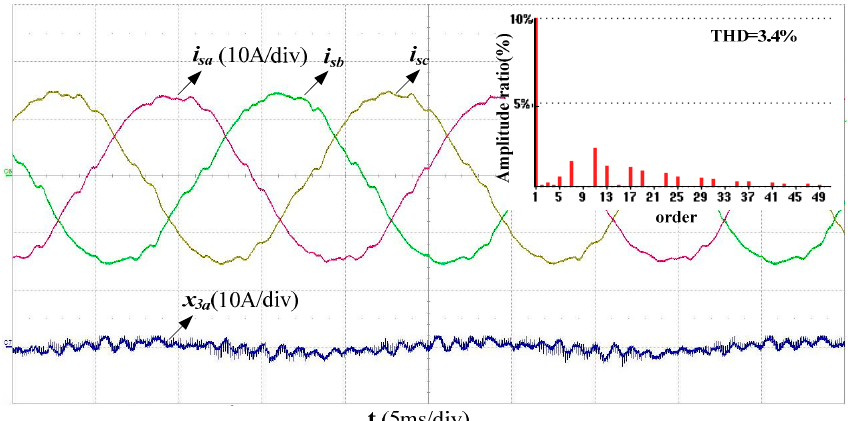
Figure 13. Experimental waveform of the grid current and harmonic error with SMC.